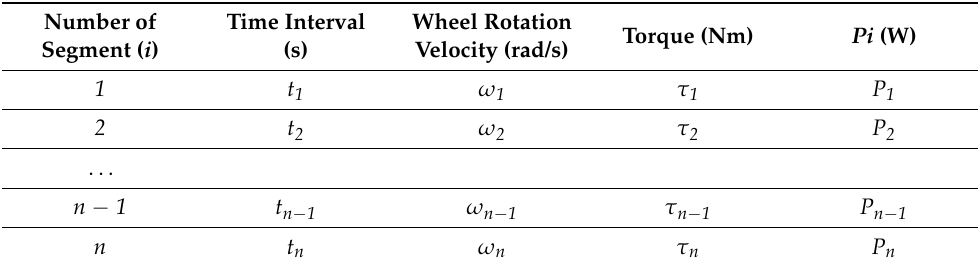
Table 1. Driving parameters of a loading diagram divided into